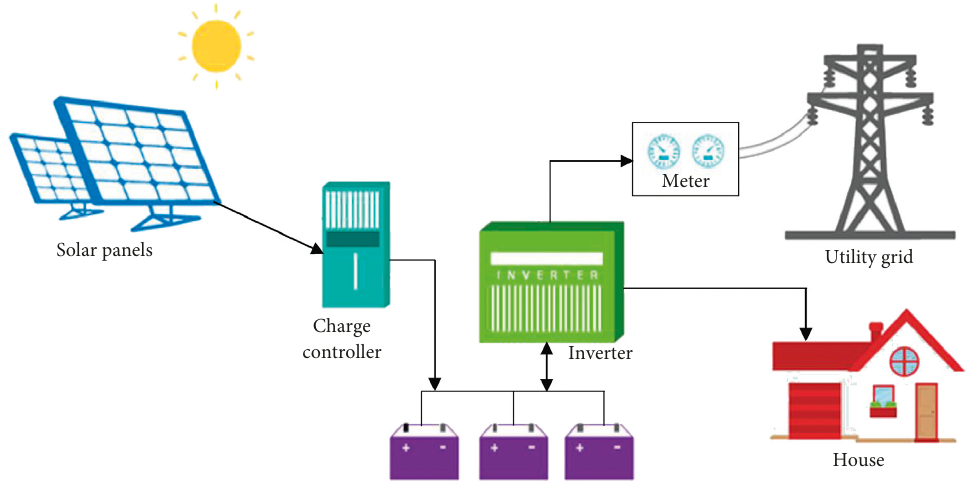
Figure 4: The installation of photovoltaic